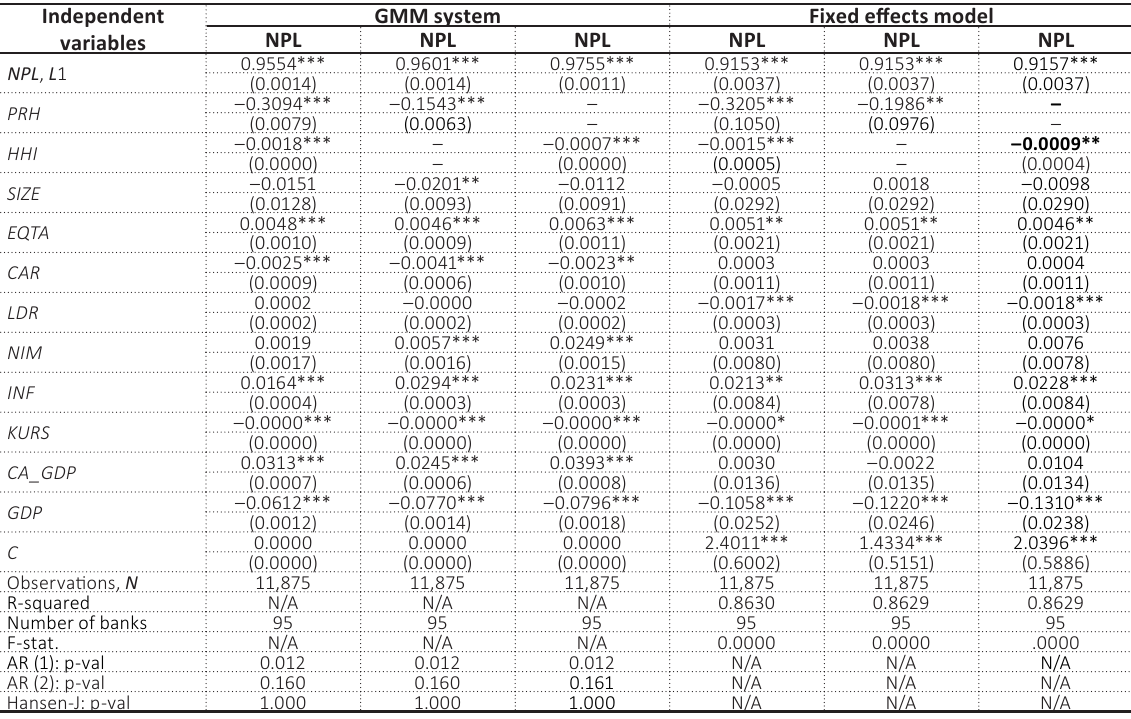
Table 5. Impact of bank competition ( PRH or HHI ) on credit risk ( NPL